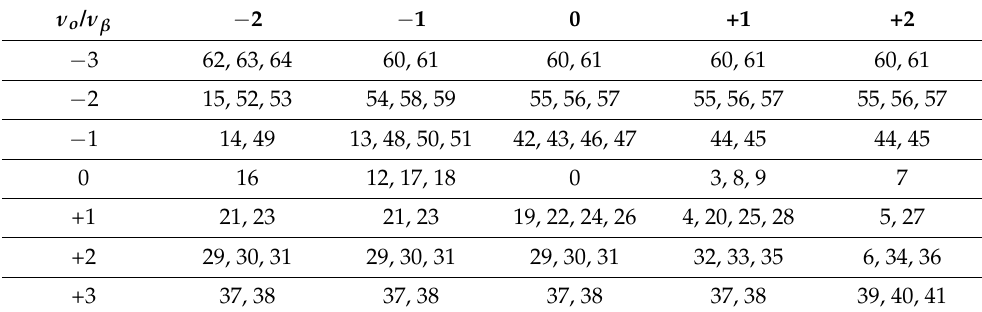
Table 3. Look-up table associated with the β o